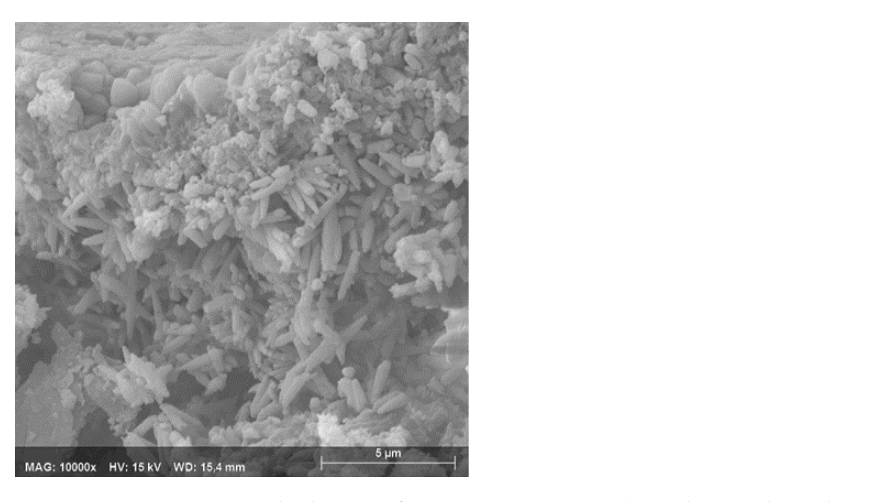
Figure 11. Hydric properties of the mortars with siliceous sand, after cycles of the water absorption: ( a ) water absorption; ( b ) water desorption.